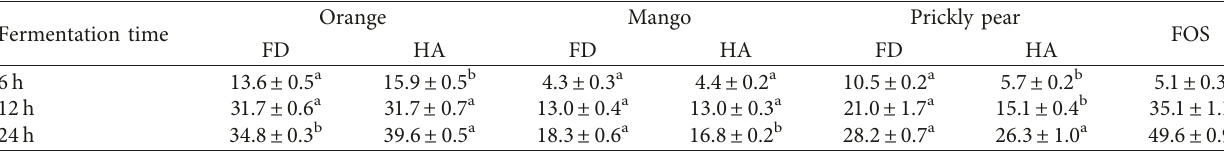
Table 5: Total SCFA production (mmol · g − 1 db) of DFC from orange, mango, and prickly pear peels freeze-dried (FD) and convective hot air-dried (HA), during in vitro faecal fermentation.